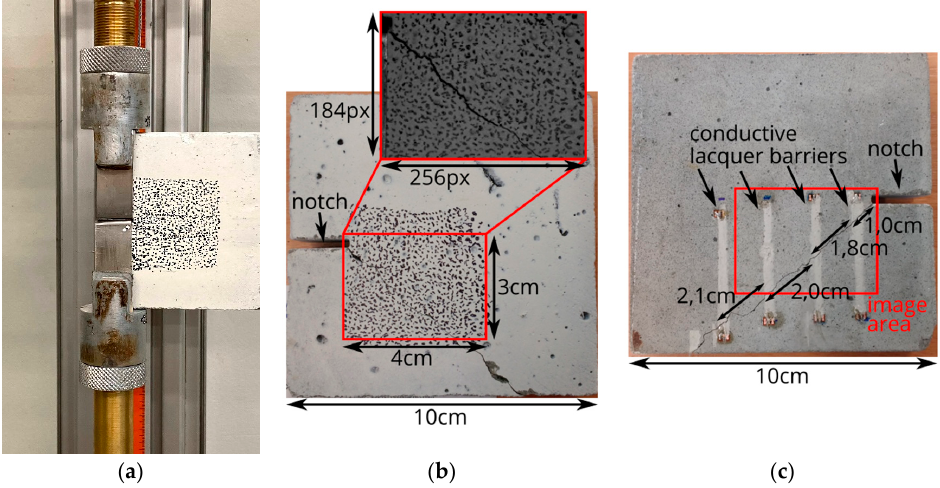
Figure 10. ( a ) Specimen in the test setup. ( b ) Front side of the specimen; ( c ) back side with four conductive lacquer barriers.